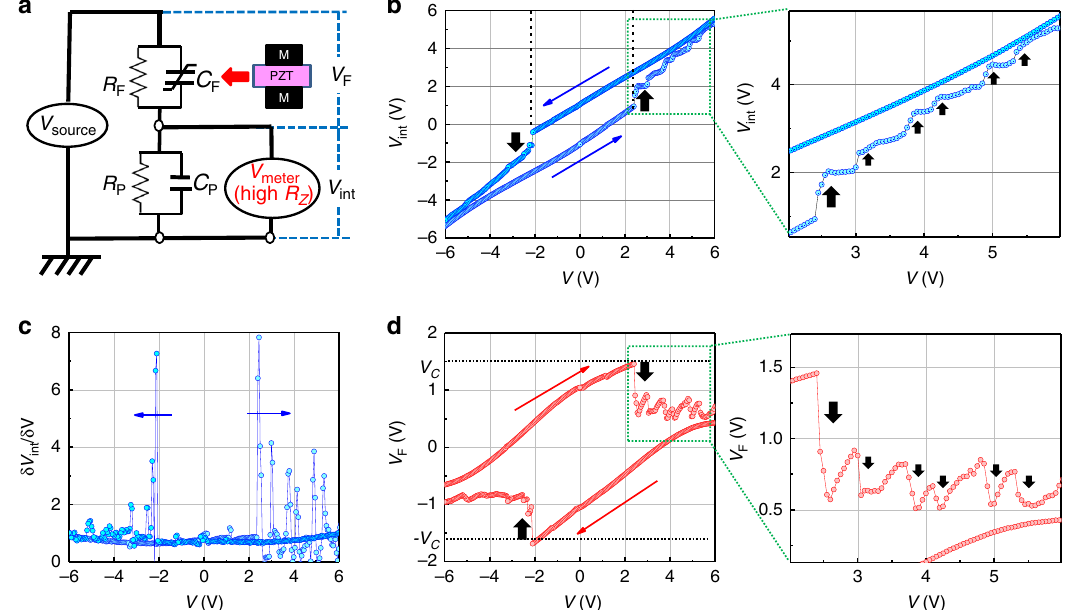
Fig. 2 V int measurement in a FE/PE stack. a Equivalent circuit of V int measurement in FE/PE system. R F and R P are the insulating resistance of FE- and PE- CAP respectively. Note that high impedance system is needed to get the accurate V int . b V int - V , c δ V int / δ V - V and d V F - V characteristics during V sweeping of FE/PE system. V int jump occur along with V F drop at V F = ~± V C , corresponding to δ V int / δ V > 1, followed by the oscillating small ones.